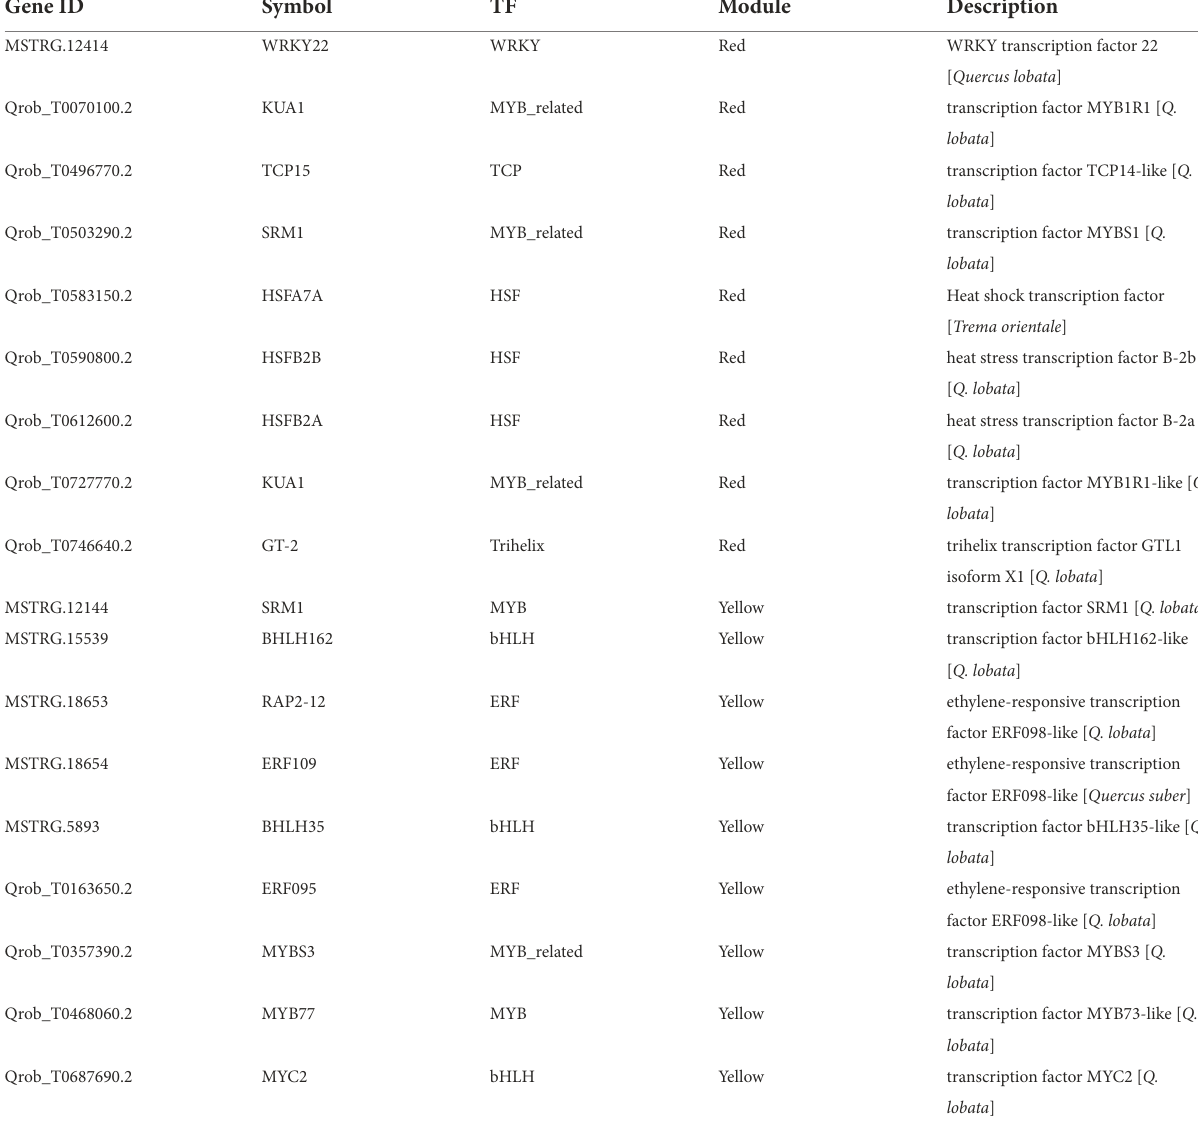
TABLE 2 The identified transcription factors in the sugars-related